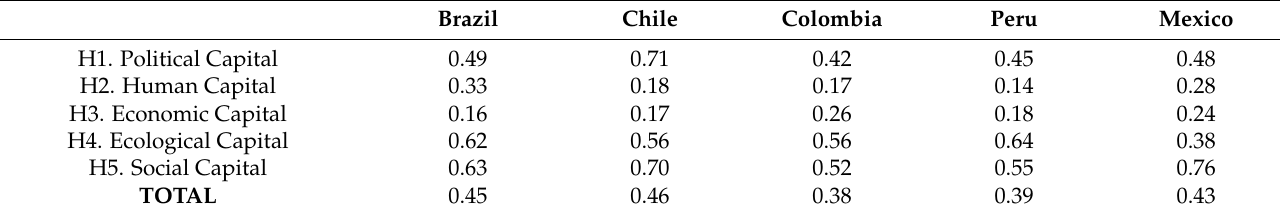
Table A4. Results of QHIM per each helix and country.